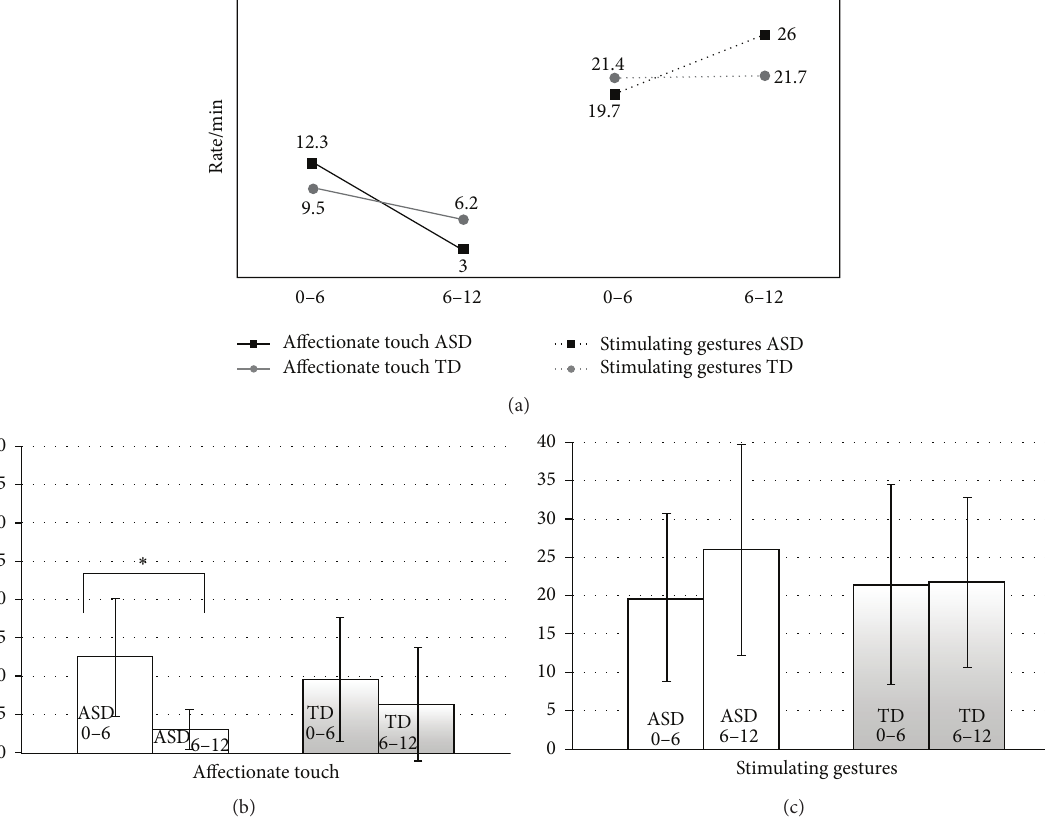
Figure 3: Trajectories of caregiver’s affectionate touch verses caregiver’s stimulating gestures. (a) Trajectories (from T1 to T2) of affectionate touch (b) and stimulating gestures (c). In the transition from T1 to T2, caregivers of infants with ASD compared to caregivers of TD infants show a significant reduction of affectionate touch, whereas the rate/min of stimulating gestures increases. (b), (c) Means and standard deviations (error bars). ∗∗ 𝑃 ≤ 0.01 ; ∗ 𝑃 ≤ 0.05